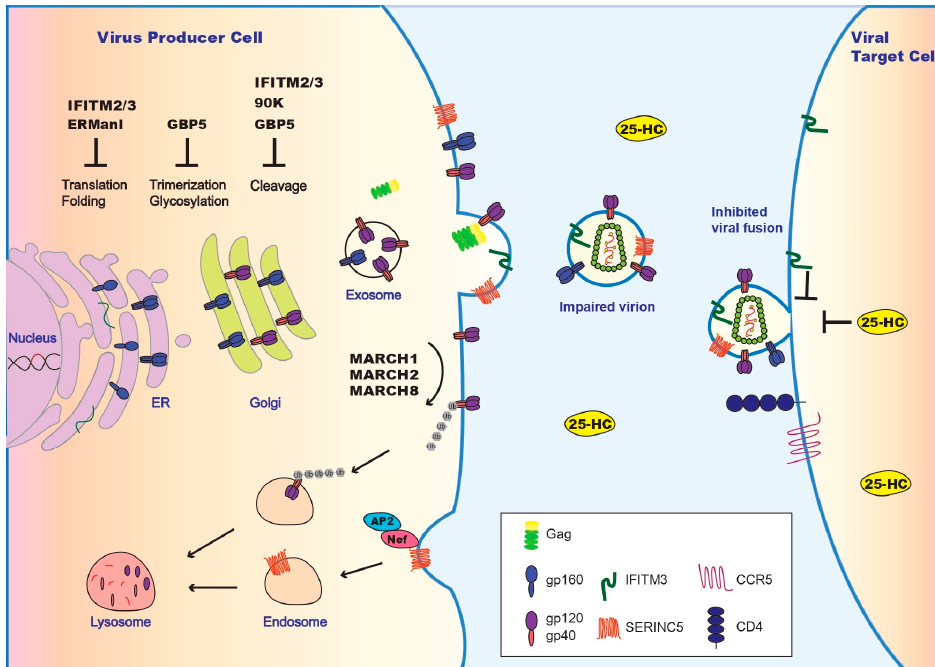
Figure 1. Inhibition of HIV-1 entry by restriction factors and viral counter measures. Illustrated are restriction factors that operate in virus producer cells and inhibit Env synthesis at the endoplasmic reticulum (ER) (by IFITM2/IFITM3 and ERManl), impair Env maturation at Golgi (by IFITM2/IFITM3, GBP5, and 90K), and downregulate Env at the plasma membrane (by MARCH1/MRCH2/MARCH8). IFITM2/IFITM3 and SERINC5 get incorporated into HIV-1 particles and impair viral membrane fusion. In virus target cells, IFITM2/IFITM3 and 25-HC deter viral entry. HIV-1 uses Nef to downregulate SERINC5. The other viral countering strategies are summarized in Table 1. A more comprehensive illustration of antiviral restriction factors is presented in [19].